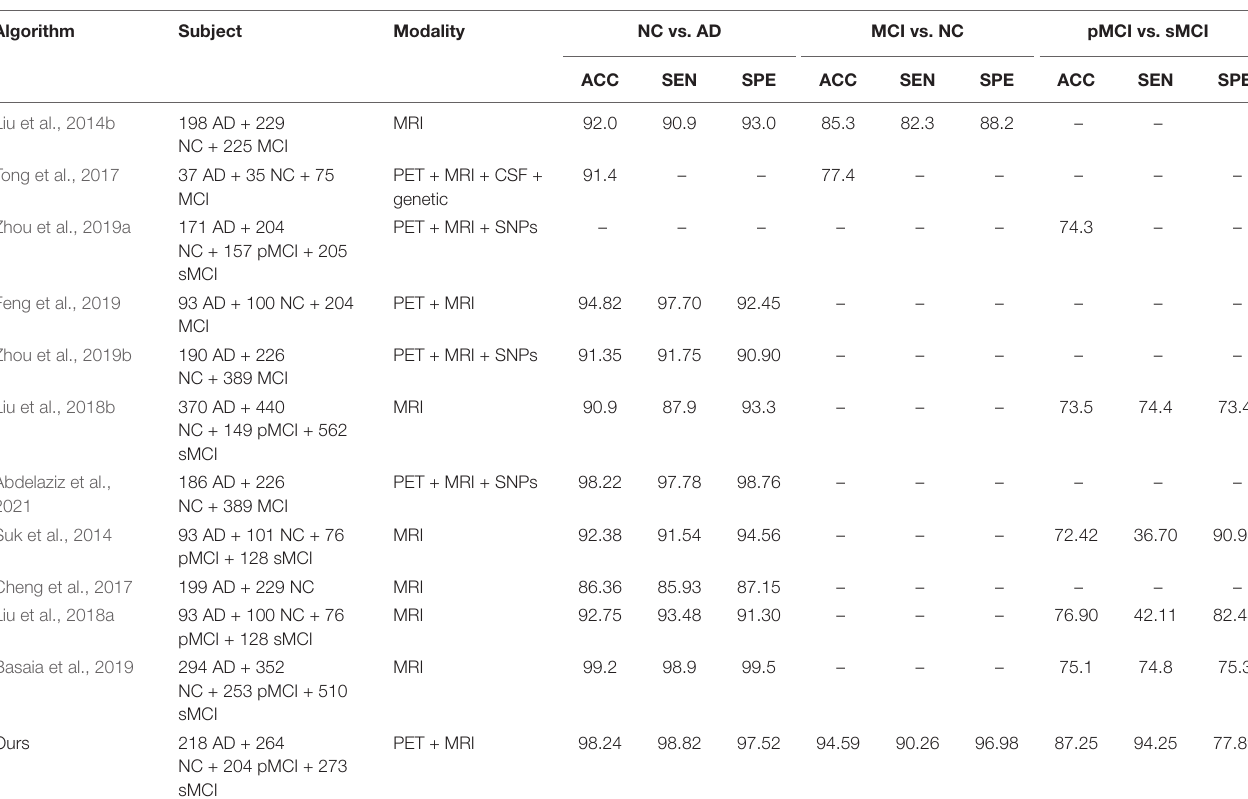
FIGURE 7 | ROC curves comparison between the standard and the proposed method for three the different classification tasks. TABLE 4 | Algorithm comparisons for the three different classification